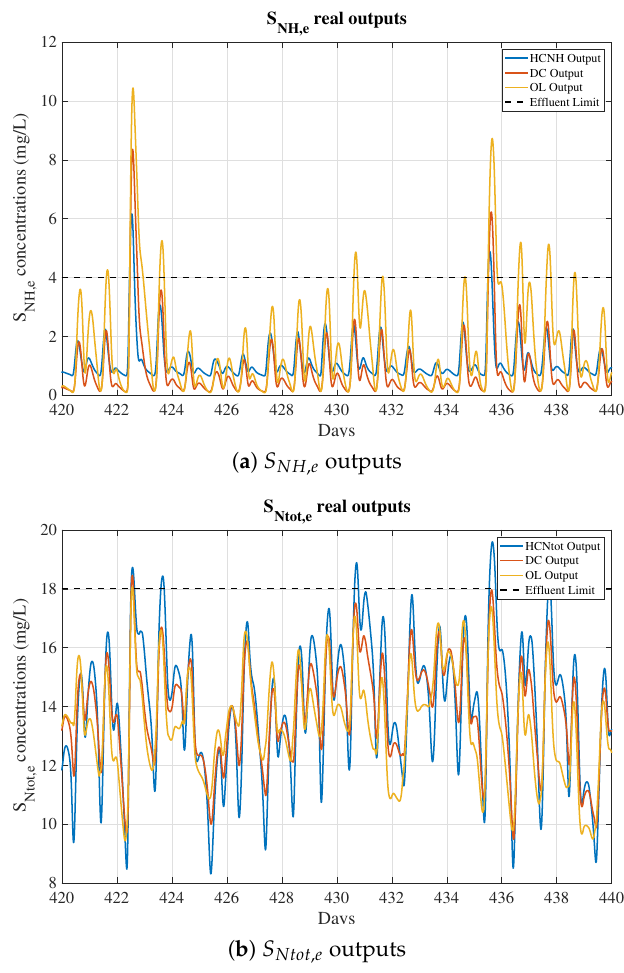
Figure 5. Real outputs for HC, DC, and OL control strategies. Notice that nearly all days are below the effluent limit, showing that measurements above the limits are clearly